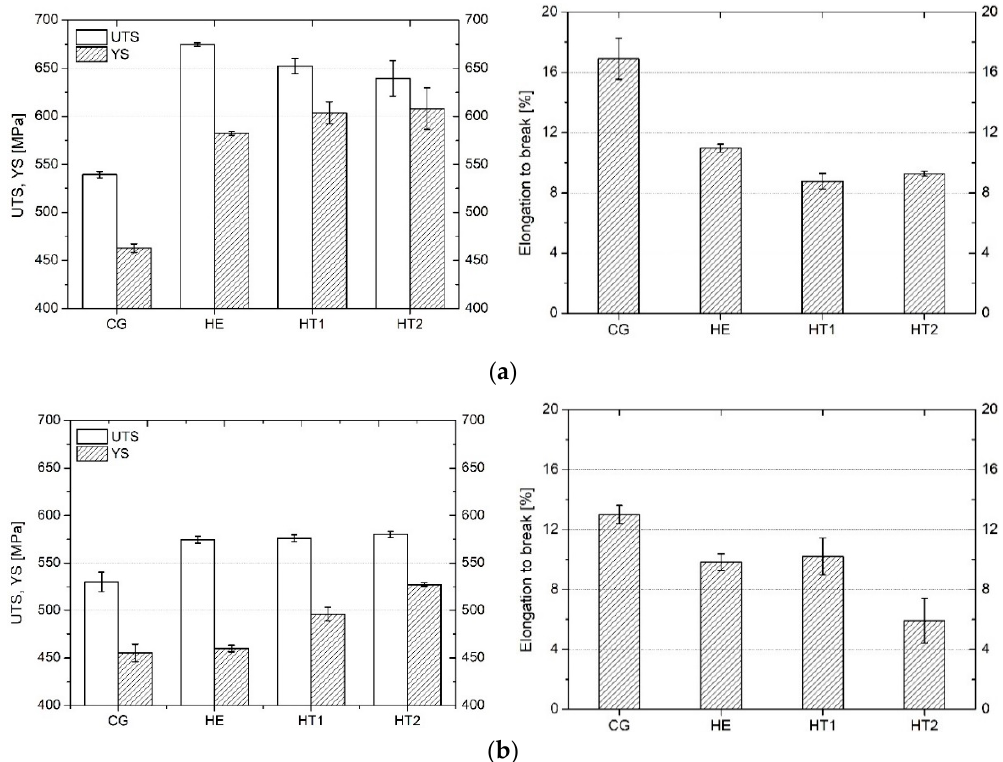
Figure 8. Values of UTS, YS, and E b for each sample, measured in the ( a ) longitudinal and ( b ) trans- verse directions with respect to the extrusion direction.